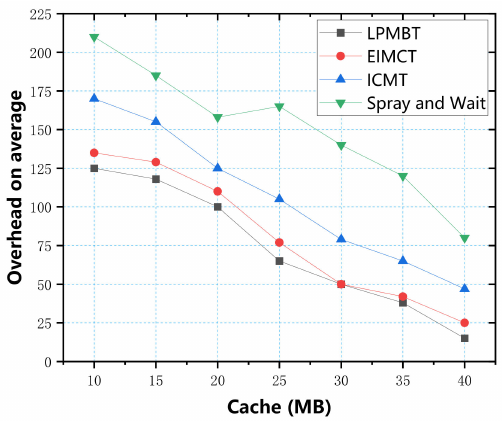
Figure 9. Overhead on